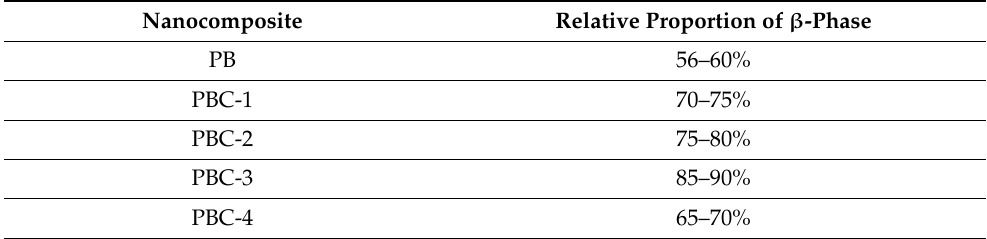
Table 1. Relative proportion of the β -phase in the nanocomposites from FTIR